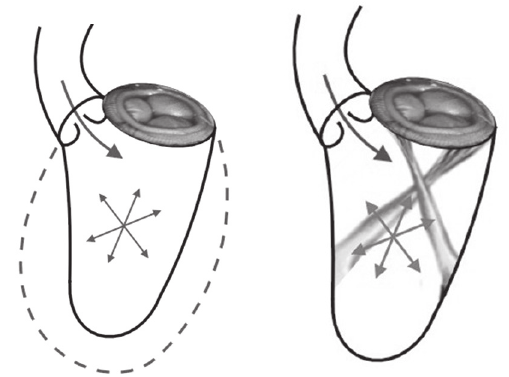
Fig. 5 – Diagrama de correlação entre dilatação passiva